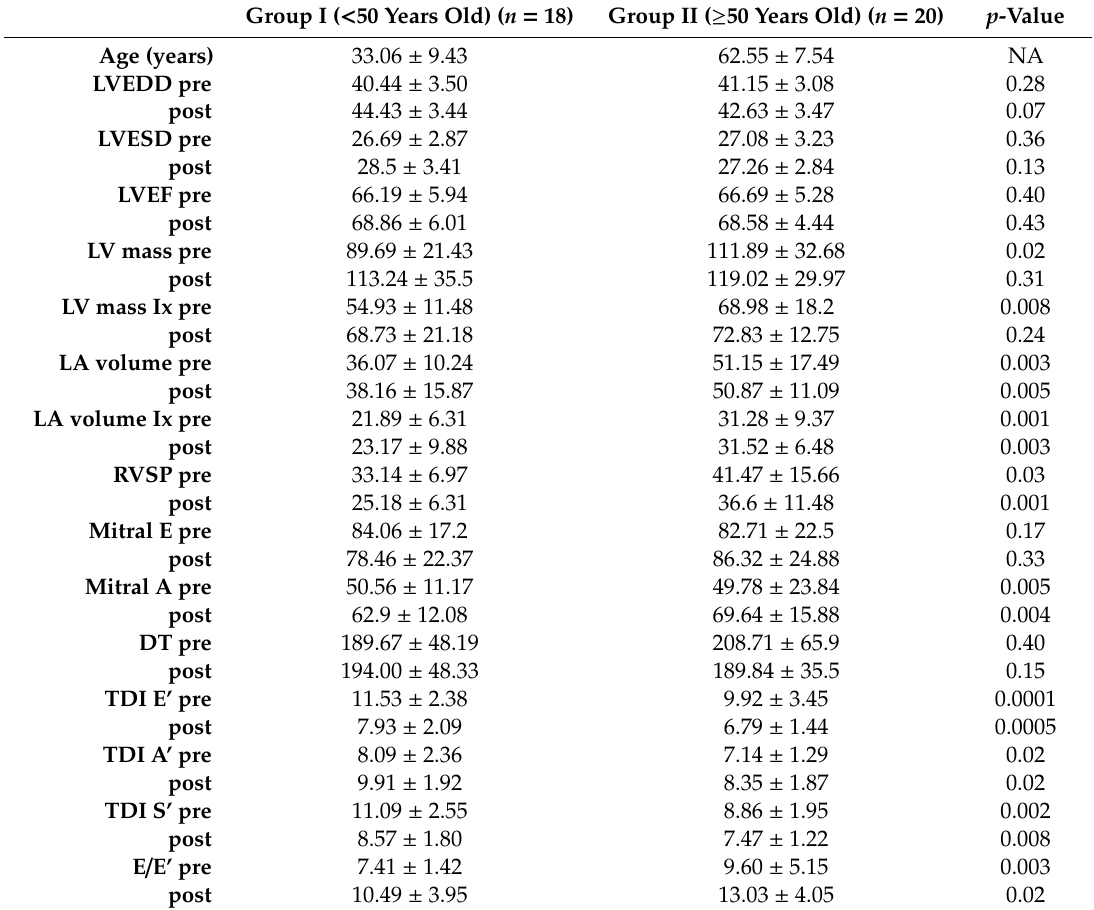
Table 2. Comparison of echocardiographic data collected before and after atrial septal defect closure in Group I (N = 18) and Group II (N =